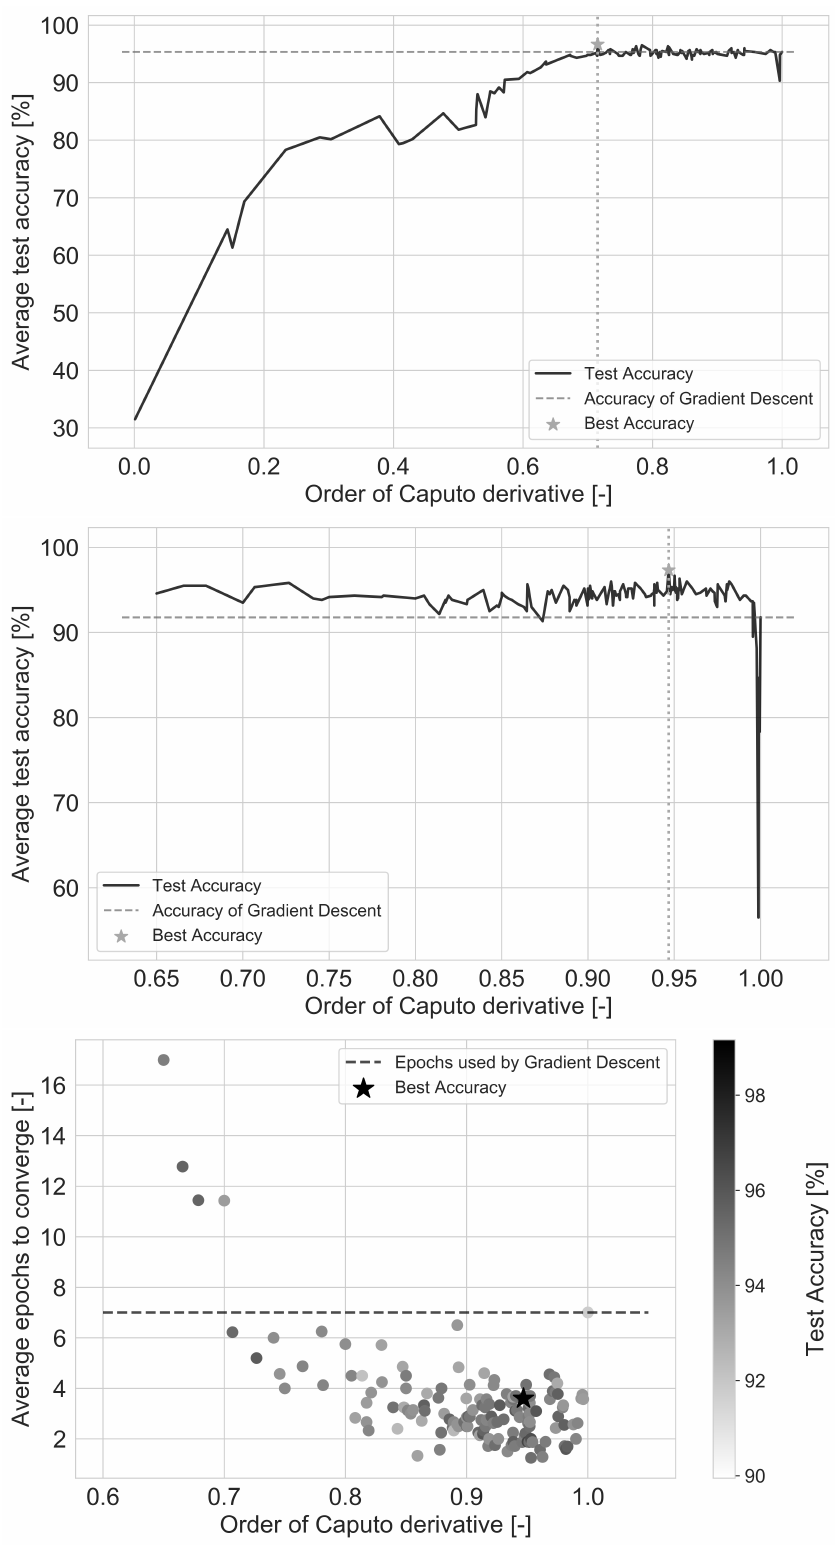
Figure 5. Average test categorical accuracy of the two PSO runs, and the average training epochs taken to reach Gradient Descent’s accuracy for the second run (from top to bottom) on the Iris